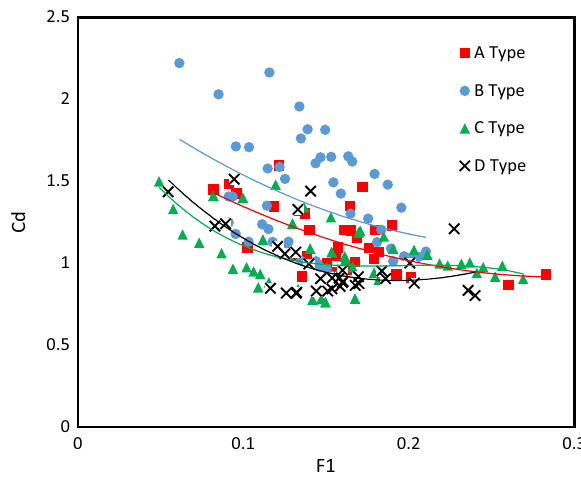
Fig. 12 A comparison between other studies and the current